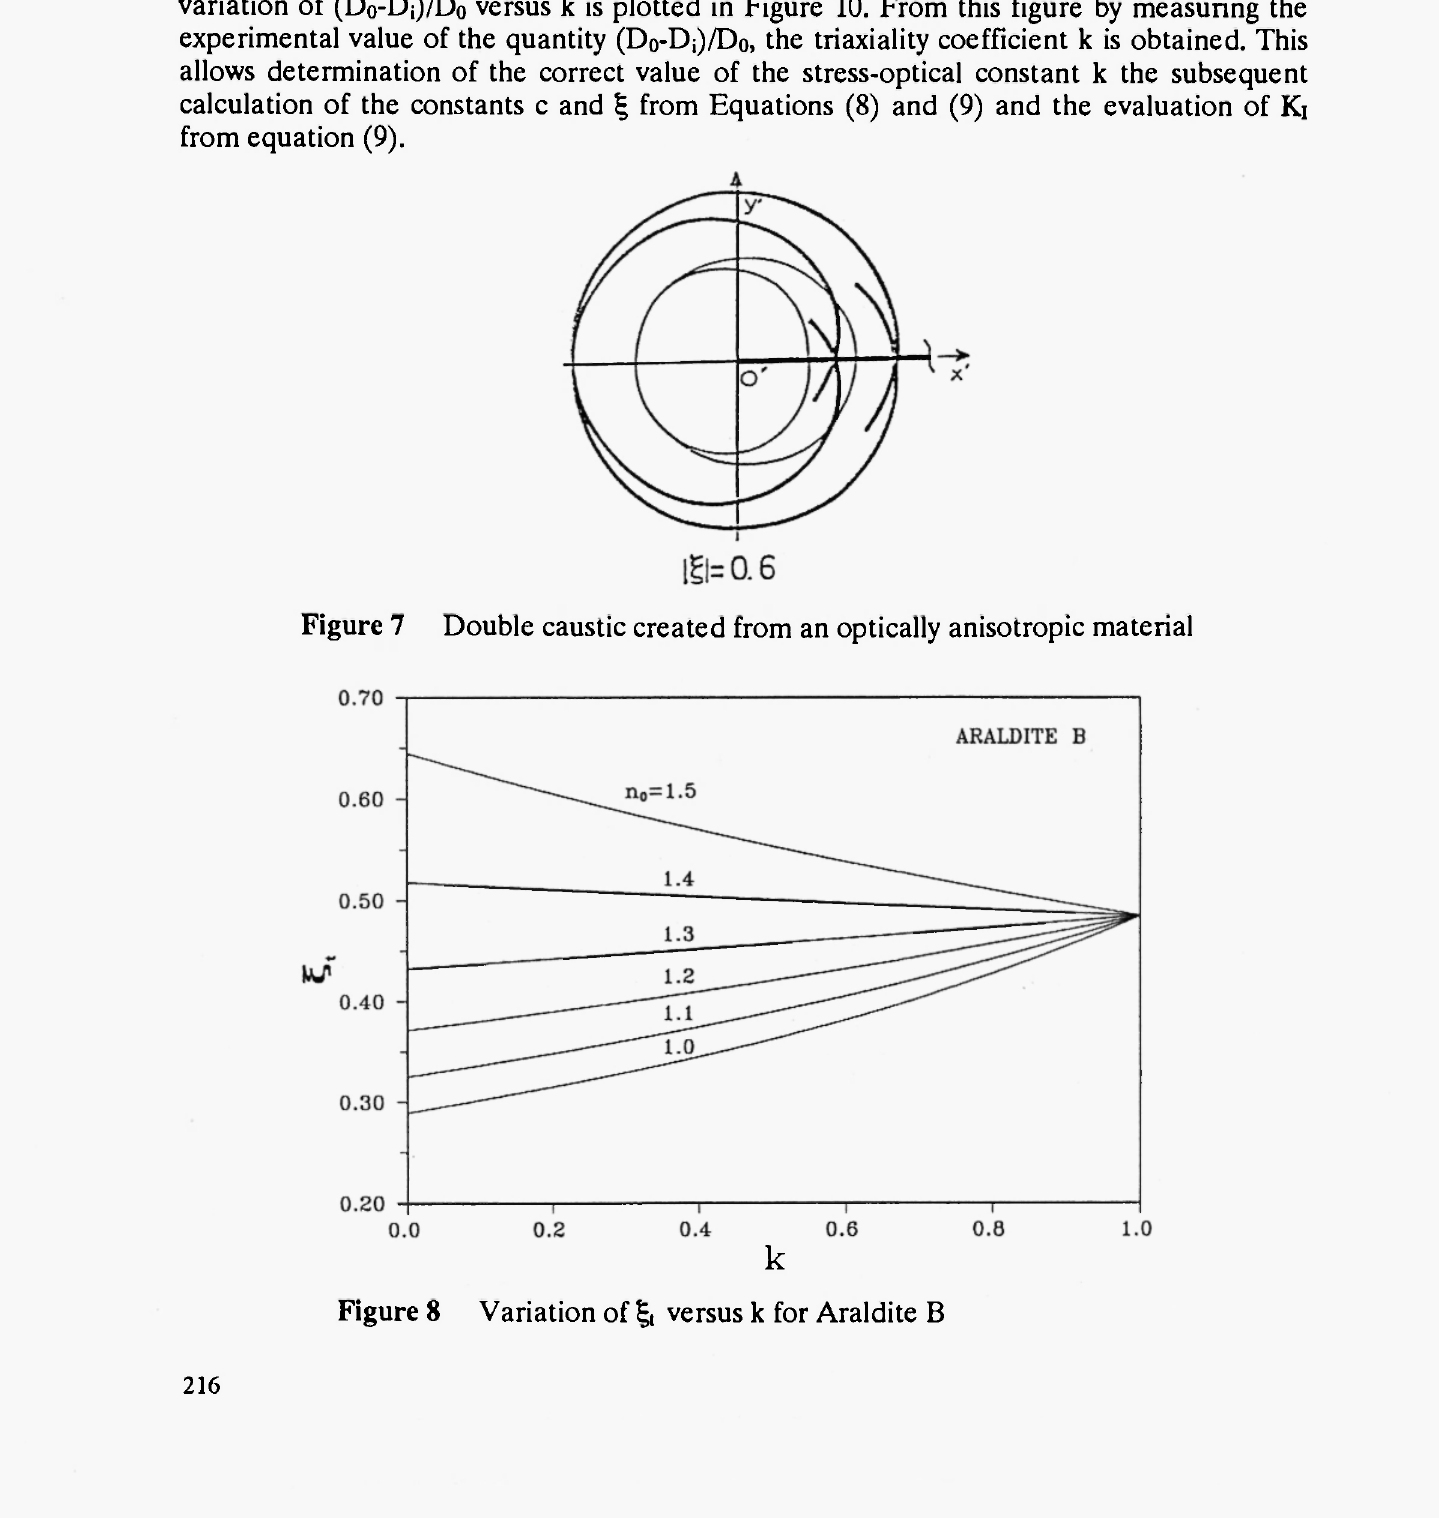
Figure 8 Variation of ξ